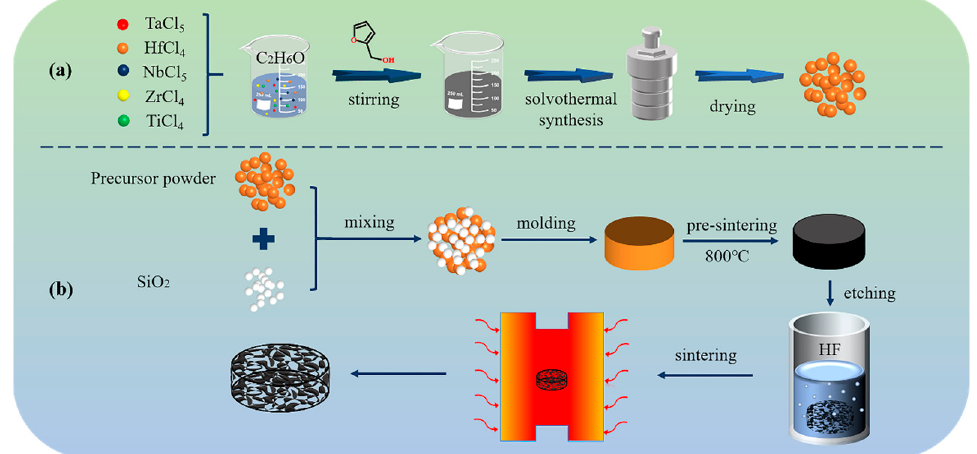
Figure 1. Schematic diagram of the preparation process of ( a ) precursor powders, ( b ) porous HECs.